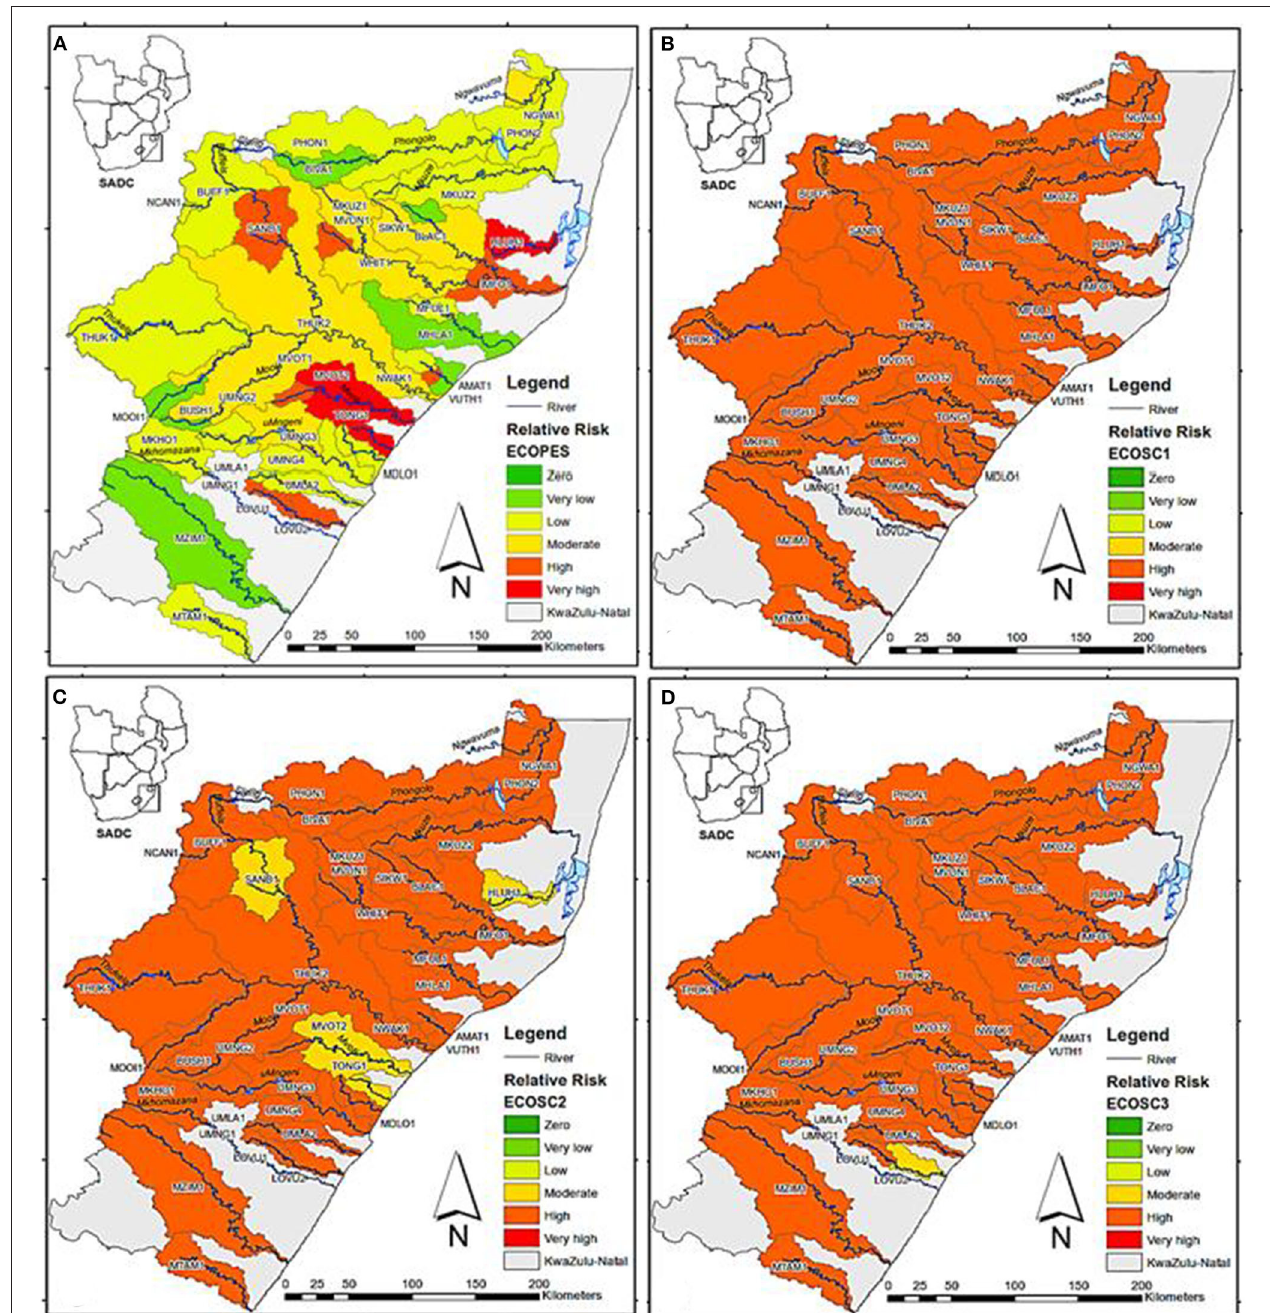
FIGURE 7 | Final ecosystem risk classifications of KwaZulu-Natal rivers studied from 2015 to 2016 based on the present ecological state (A) ; risk associated with low flow (B) ; risk associated with limited or degraded habitat (C) ; and risk associated with poor water quality (D)